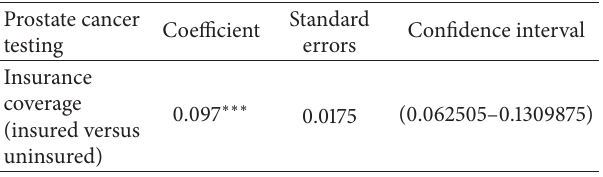
Table 5: Average effects of insurance coverage on prostate cancer testing using kernel-based propensity score matching.